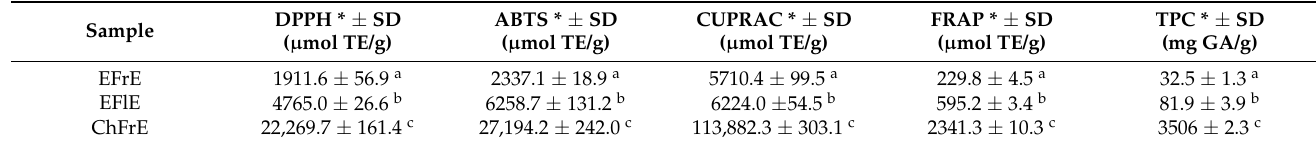
Table 1. Antioxidant capacity and total phenolic content in plant extracts added to chocolates.